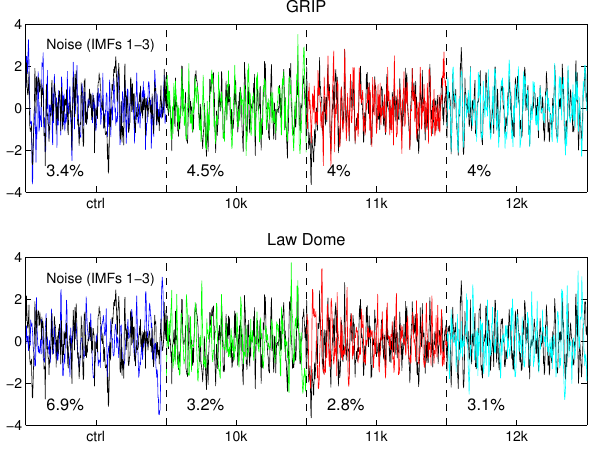
Fig. 10. The standardised reconstructed high-frequency “noise” (IMFs 1–3) from the 10 Be deposition for the four simulations, shown with the same standardised high-frequency components of precipitation (black). The percentages show the variability explained by the ’noise’ components in each simulation.